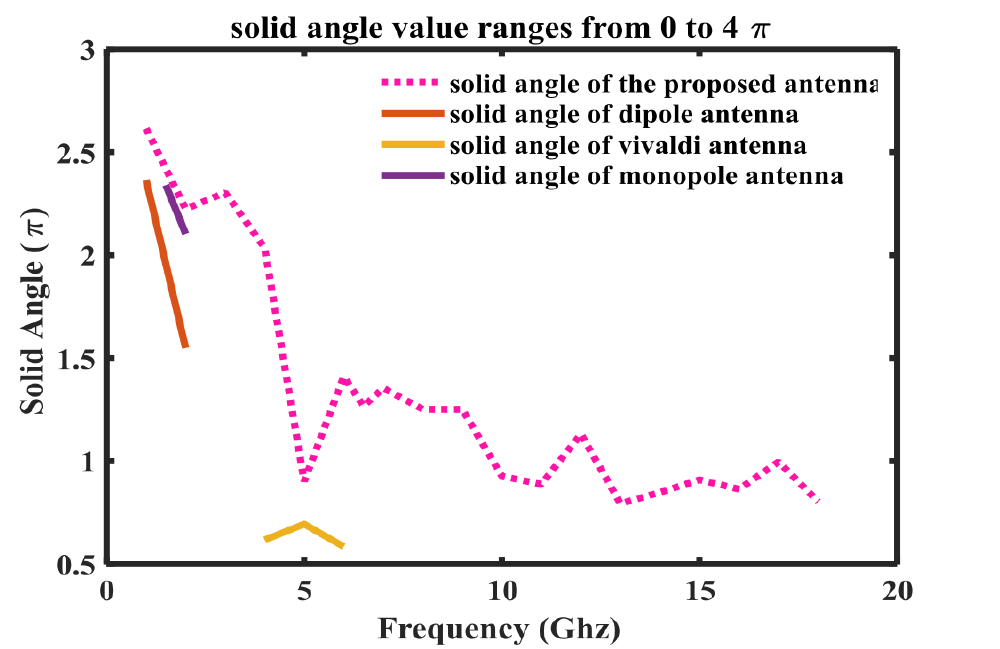
Figure 9. Solid angle of different